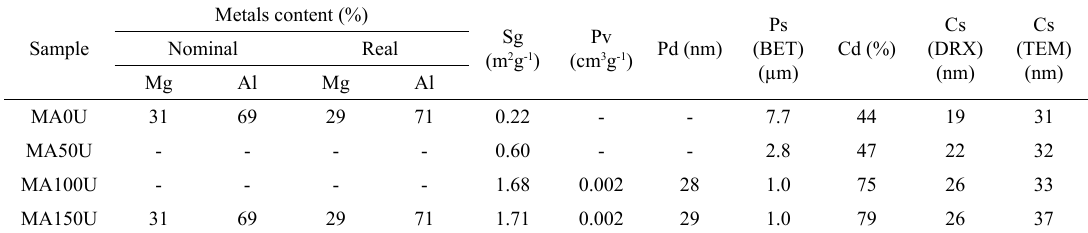
Table 1. Values of: metal contents, specific surface area (Sg), pore volume (Pv), average pore diameter (Pd), particle size (Ps), calculated from (BET), crystallinity degree (Cd), crystallite size (Cs), determined by XRD and TEM.